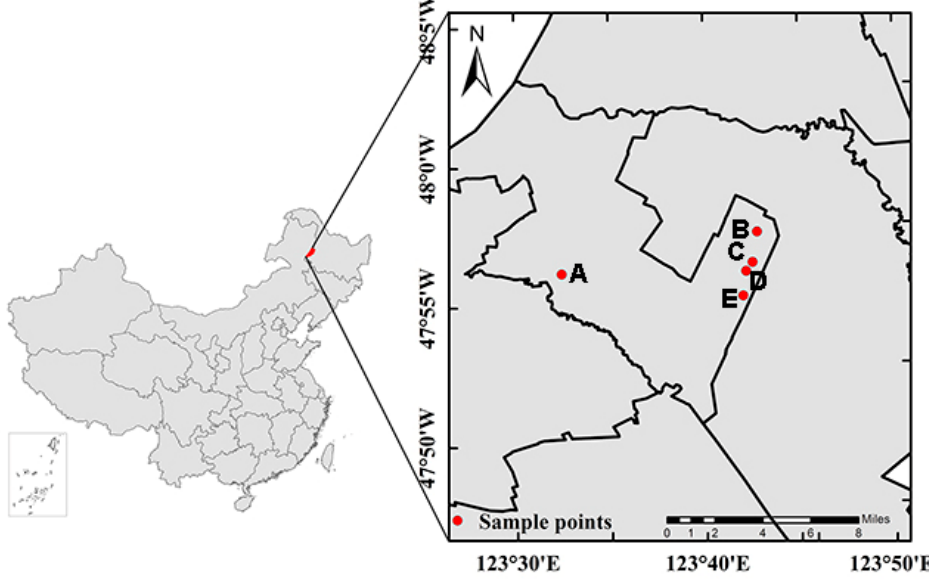
Figure 2. Five study sites (A, C, D, and E each contain five shelterbelts; B contains four shelterbelts). The study sample area only had severely degraded and non-degraded